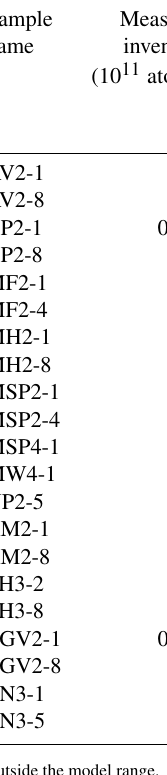
Table 3. Estimated exposure durations using the relationship be- tween maximum 10 Be concentration and the calculated inventory; see Fig. 7 (Graly et al.,